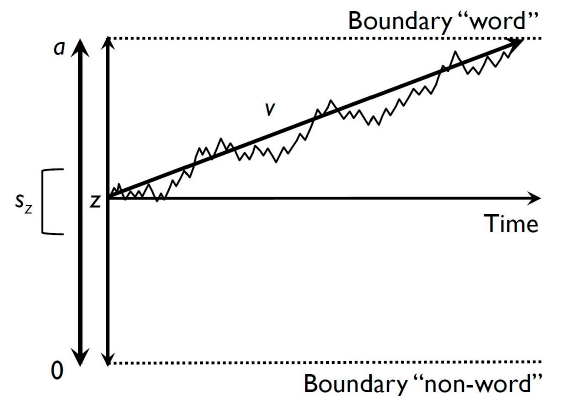
Figure 1. Illustration of the central parameters of the diffusion model for a lexical decision task. Note: a = boundary separation, z = starting point s z = variation in starting point, v = drift rate. Note that the nondecision time t 0 is not illustrated since it also involves processes of response preparation.